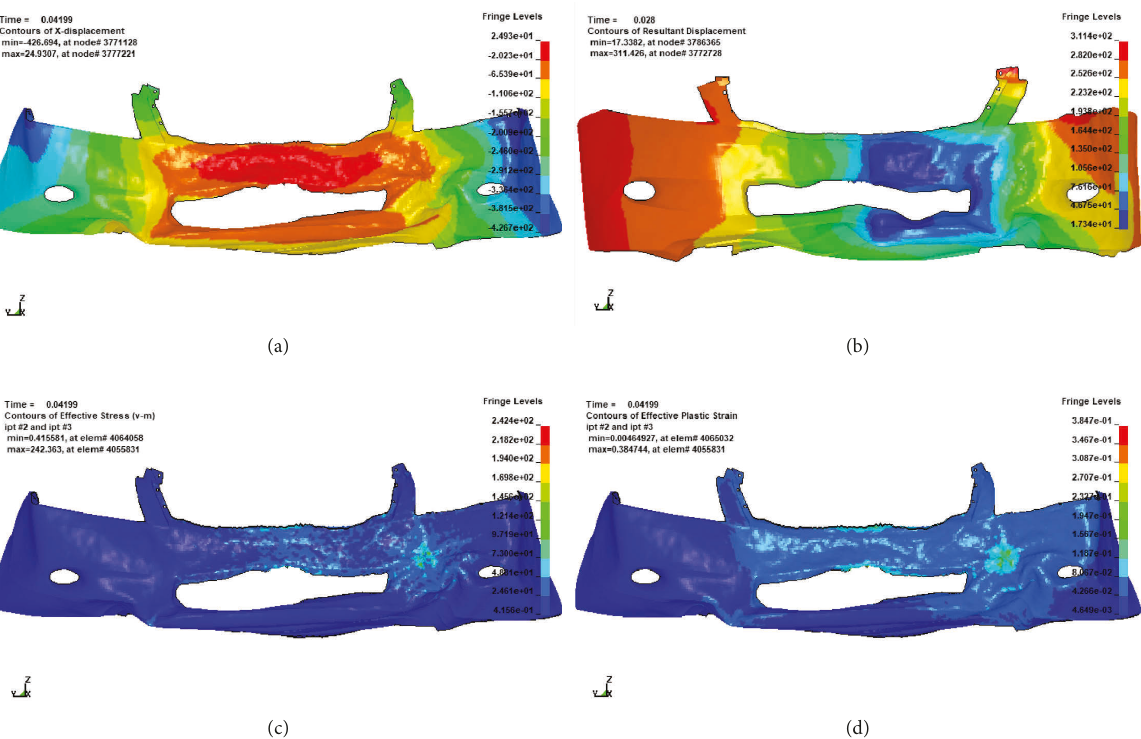
Figure 8: Crash test simulation results by using FEA (a) resultant displacement of the frontal crash of basalt fibre (b) resultant displacement of the frontal crash of basalt fibre with aluminium (c) effective von Mises stress (d) effective plastic